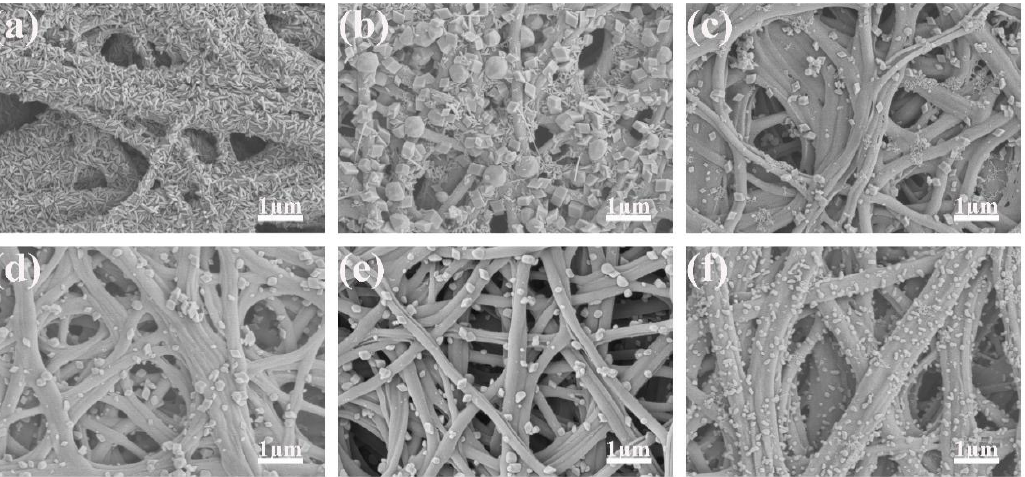
Figure 2. SEM images of Fe 2 O 3 /CNFs (effect of temperature): ( a ) 130 °C; ( b ) 140 °C; ( c ) 150 °C; ( d ) 160 °C; ( e ) 170 °C; ( f ) 180 °C.